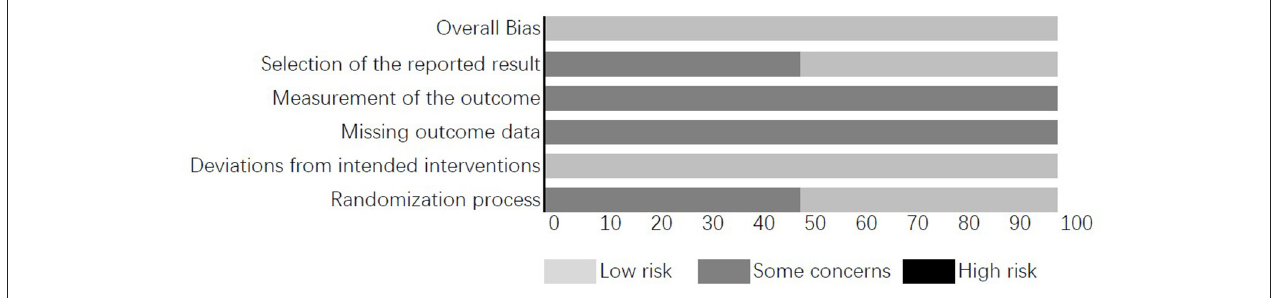
FIGURE 2 | Assessment of the risk of bias in the included